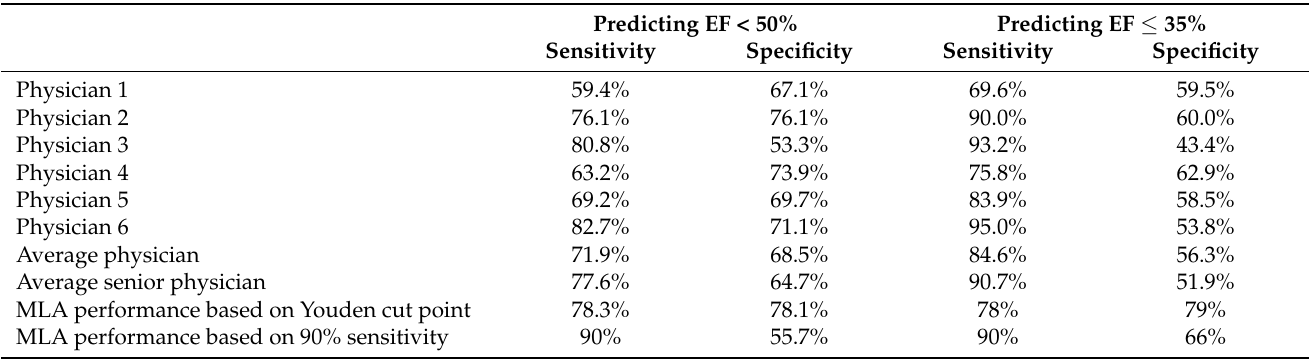
Figure 2. Receiver operating characteristic curve and physician performance for predicting left ventricular systolic dysfunction from 12-lead ECG (Area under the curve = 0.85). Table 3. Physicians and Machine learning algorithm for predicting abnormal ejection fraction (%) from a standard 12-lead ECG. Predicting EF < 50%